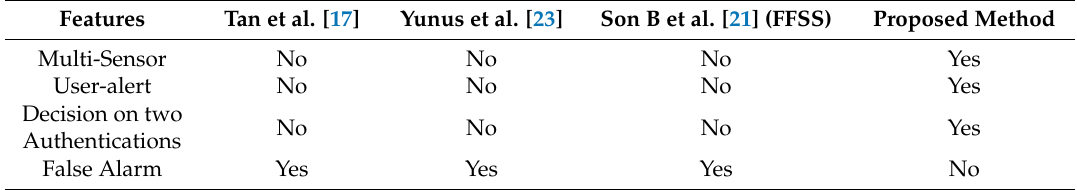
Table 4. Comparison of the proposed method with some existing work.